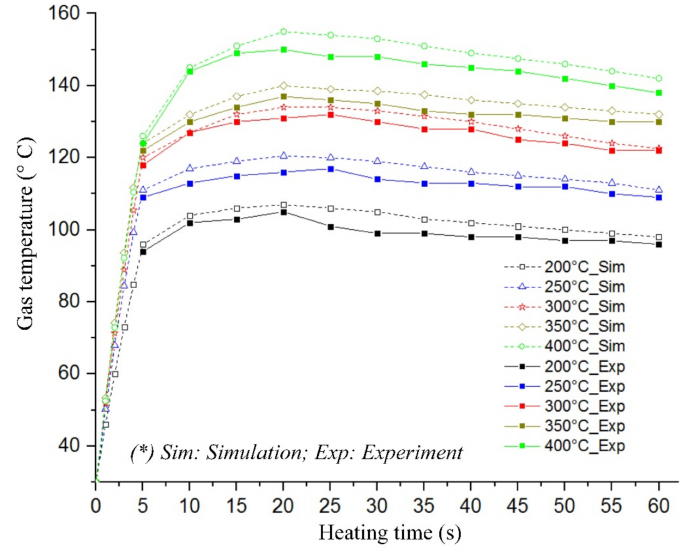
Figure 13. Heating process comparison between simulation and experiment. Table 2. Molding parameters for the weld line appearance